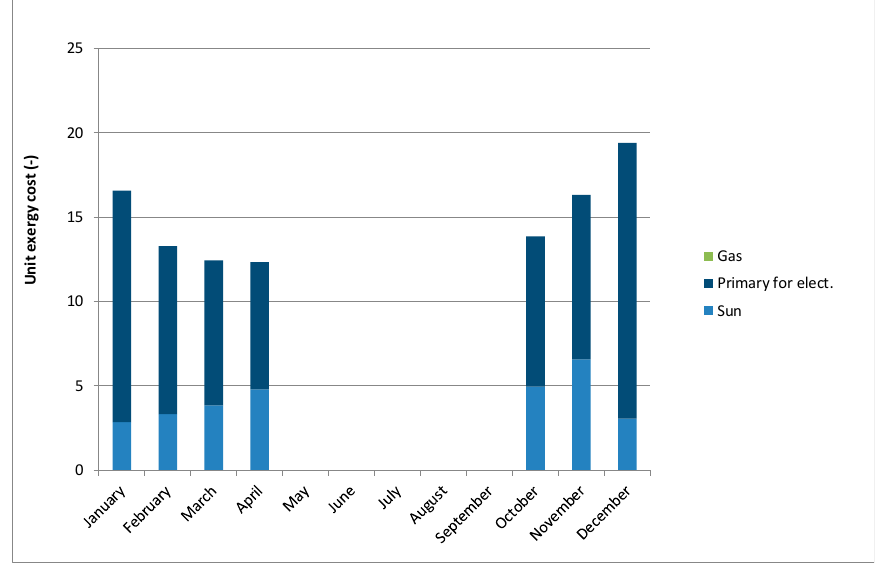
Figure 21. Heat pump: Cost formation by irreversibility.